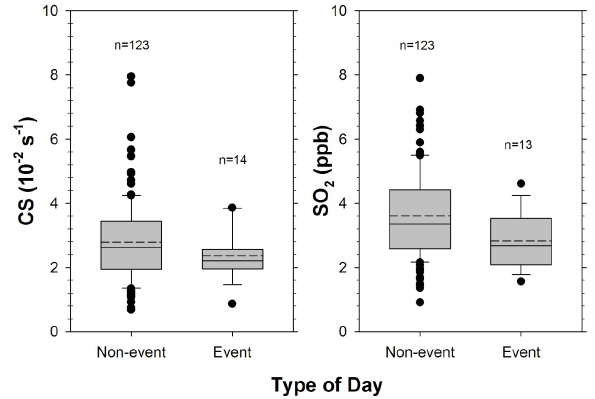
Fig. 2. Boxplots of the daily condensation sink (CS) and SO 2 for non-event and event days. The solid and dash line inside the box is the median and mean, respectively; the n is the number of days and the whiskers mark the 10th and 90th